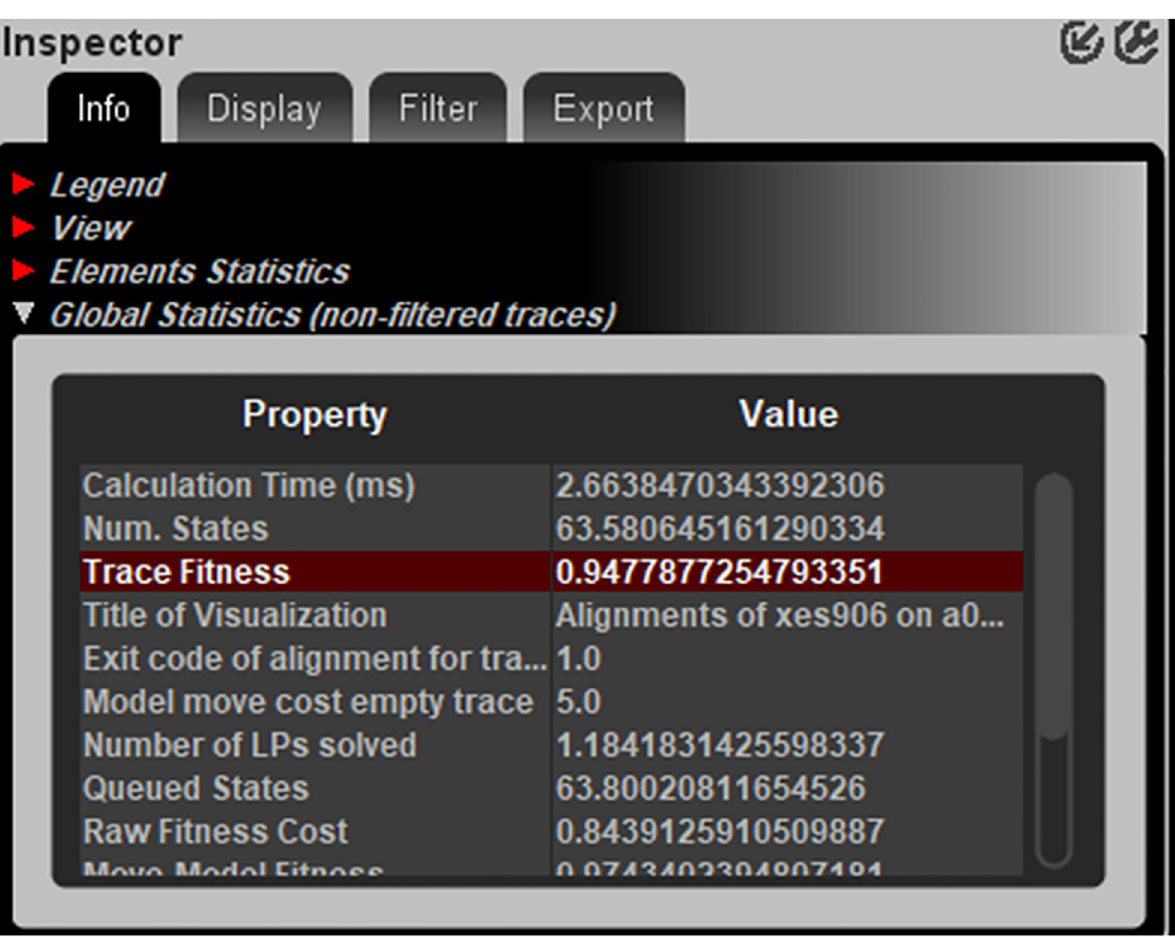
Fig 16. The statistical information obtained from replay Petri net based on petri net from inductive miner with extracted log.